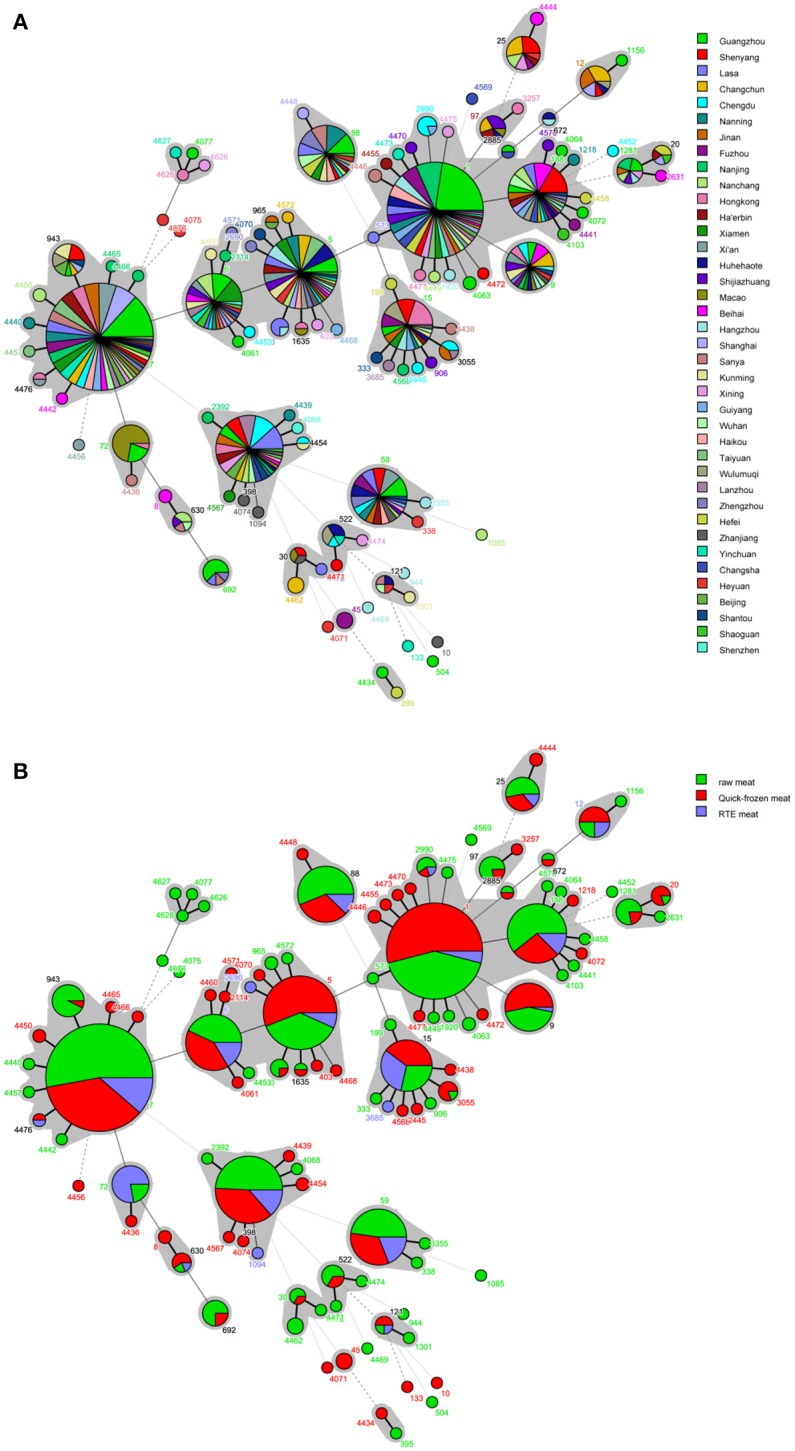
Minimum spanning tree of MLST data for 868 S. aureus isolates. Each circle represents one ST, the size of which is related to the number of strains within this ST, while the branch numbers account for the number of allele differences between connected STs. The colors in the circles in (A) represent the sampling locations, and the colors in the circles in (B) represent the food sources. The gray zones surrounding some STs indicate that these genotypes belong to the same clonal complex.